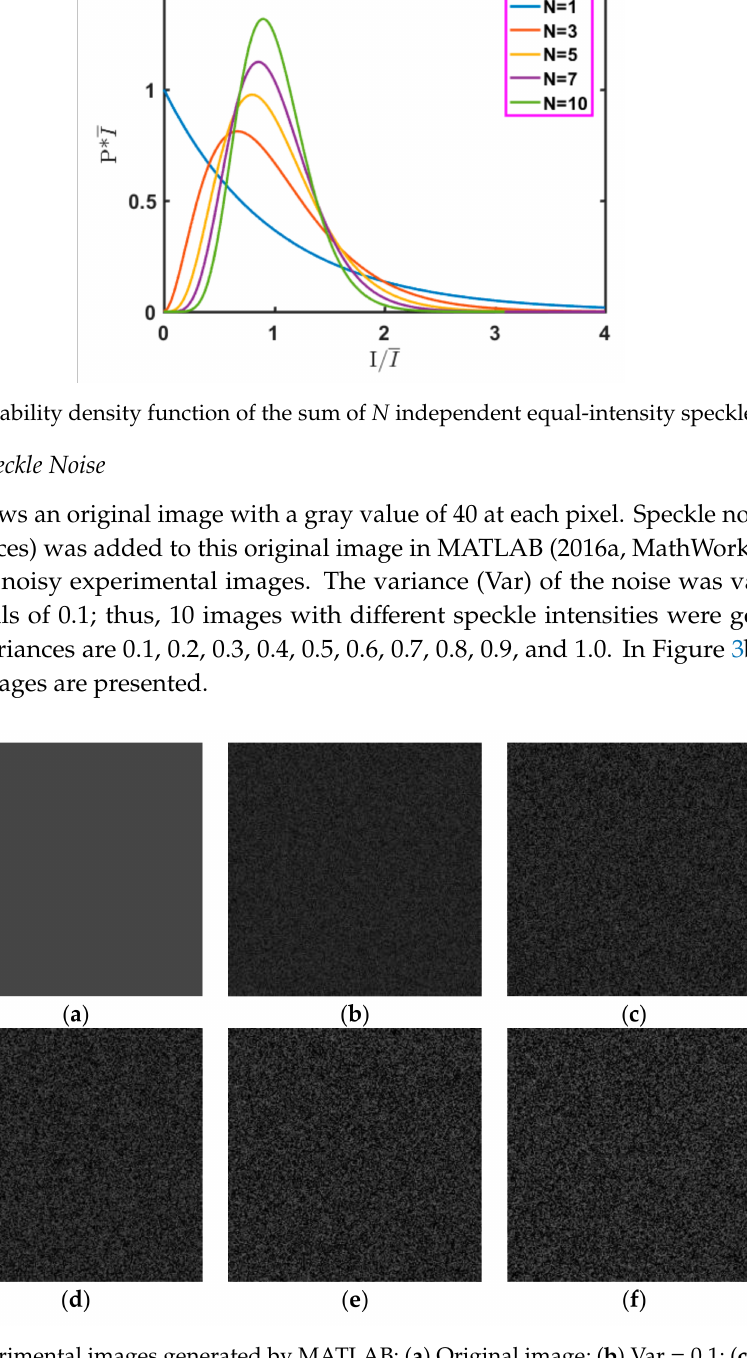
Figure 3. Experimental images generated by MATLAB: ( a ) Original image; ( b ) Var = 0.1; ( c ) Var = 0.3; ( d ) Var = 0.5; ( e ) Var = 0.7; ( f ) Var =